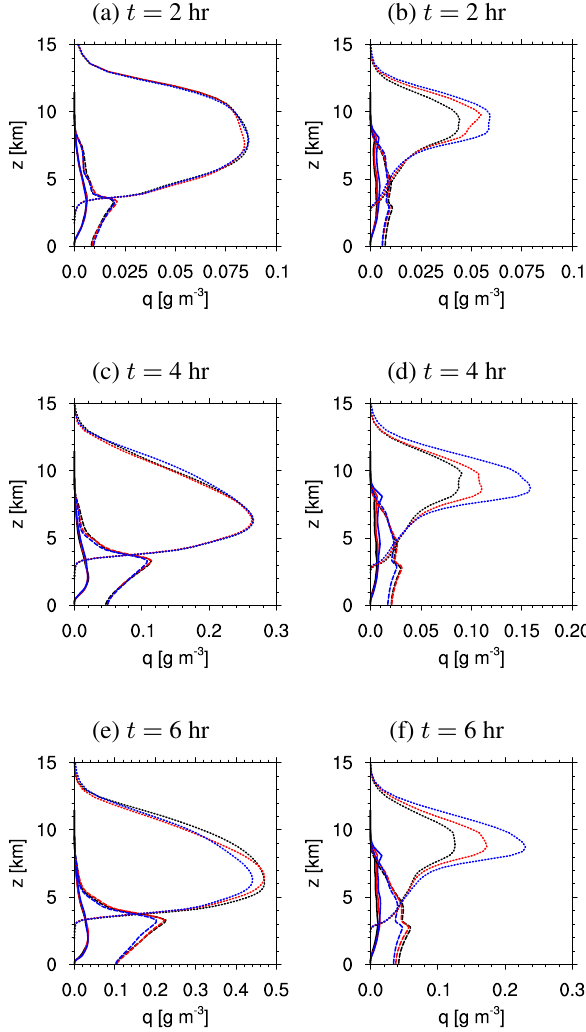
Fig. 12. Same as Fig. 6 except for the lowRH simulations. Simula- tion time is shown in the Fig. 12: Same as Fig. 6 except for the lowRH simulations. Simulation time is shown in the subcaptions.